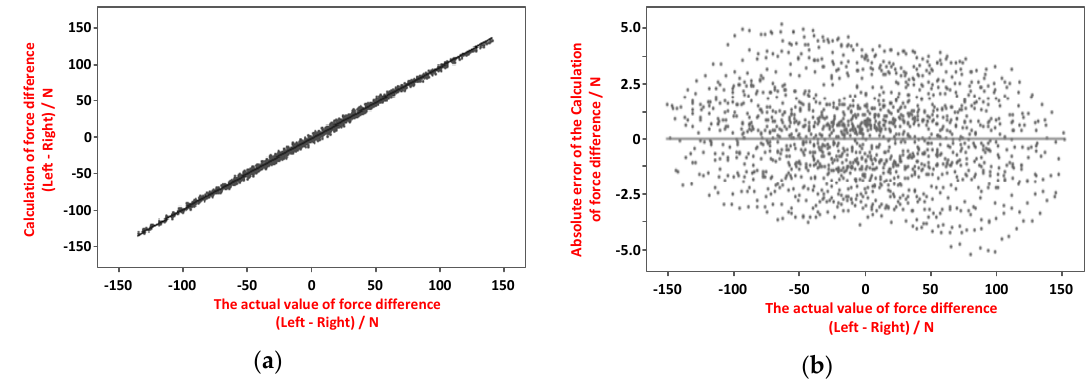
Figure 17. Contact force imbalance measurement: ( a ) measured force difference vs. actual force difference, ( b ) force imbalance measurement error vs. actual force difference.